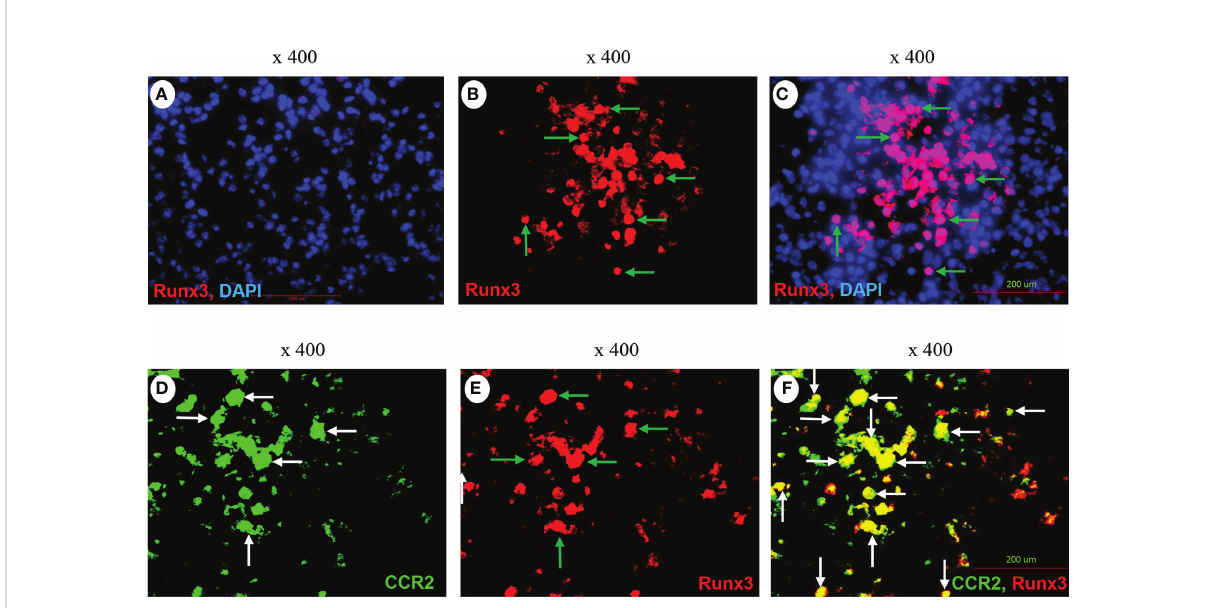
FIGURE 8 Immuno fl uorescence detection of Runx3 co-localization with CCR2 + immune cells in IAV-infected mouse lungs. (A – C) Immuno fl uorescence (IF) detection of Runx3 in IAV-infected mouse lungs. Lung sections from saline-treated (Mock, A ) or H1N1-infected mice on day 7 pi (B,C) were subjected to IF staining with a Runx3 monoclonal antibody followed by Alexa Fluor 568-labelled goat anti-mouse secondary IgG (n = 6/group). Runx3 immunoreactivities are stained red ( B , green arrows), cell nuclei stained blue by DAPI, and merged pink (C) . (D – F) Co-localization of Runx3 with CCR2 + immune cells in IAV-infected mouse lungs. Lung sections from H1N1-infected mice were subjected to IF staining with a FITC-labeled CCR2 polyclonal antibody and a Runx3 monoclonal antibody followed by Alexa Fluor 568-labelled goat anti-mouse secondary IgG (n = 4). CCR2 is stained green ( D, white arrows), Runx3 red ( E, green arrows), and merged yellow ( F, white